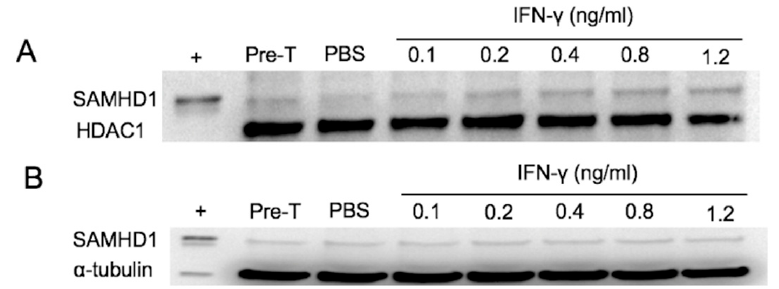
Figure 2. Detection of SAMHD1 by Western blotting in nuclear ( A ) and cytoplasmic ( B ) extracts of FeTJ cells treated with different concentrations of IFN γ for 6 h. Samples were collected pre-treatment and at 6 h post-treatment. HDAC1 and α -tubulin antibodies were used as nuclear and cytoplasmic protein loading controls, respectively.